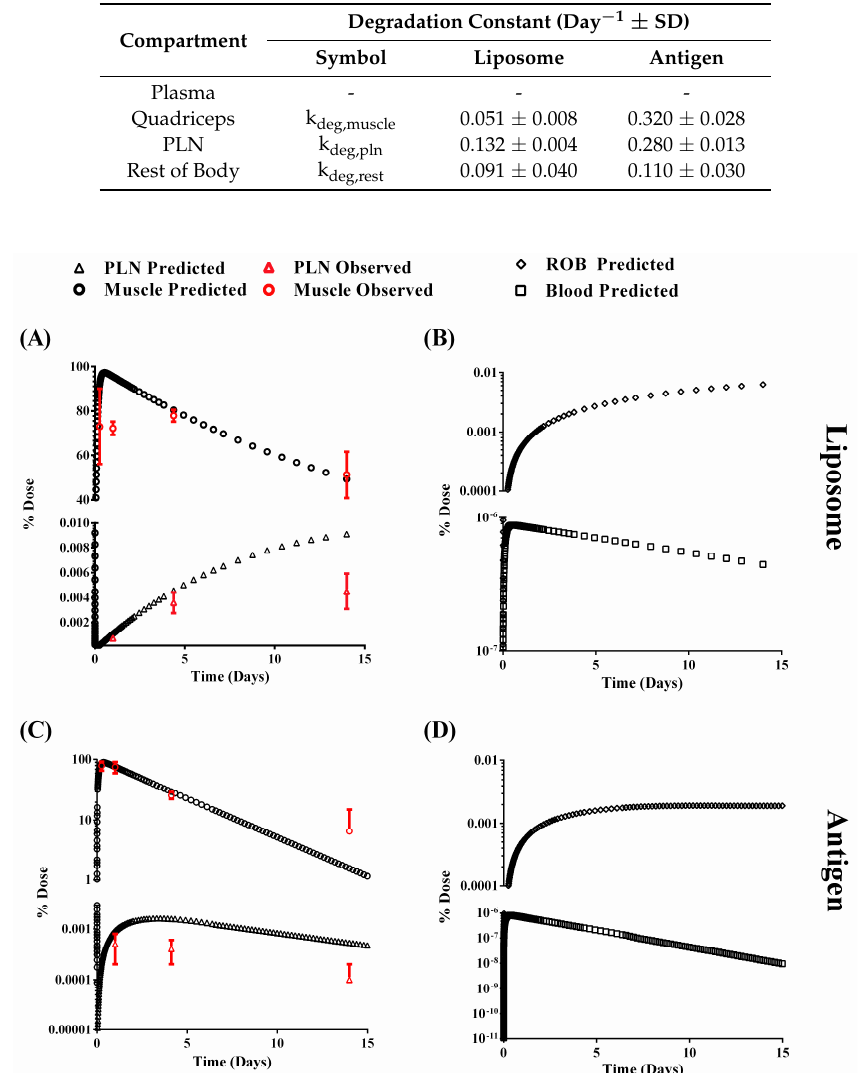
Table 4. Parameter estimates for k deg .